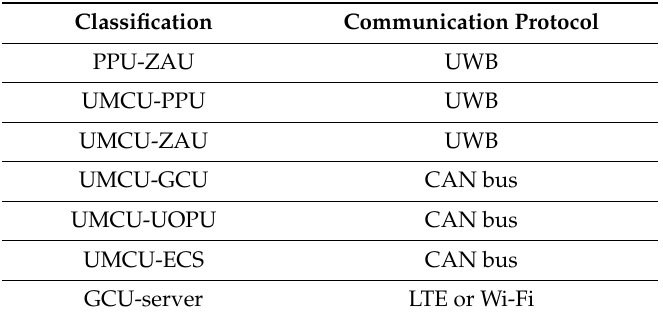
Table 2. Communication protocols of RCSS.